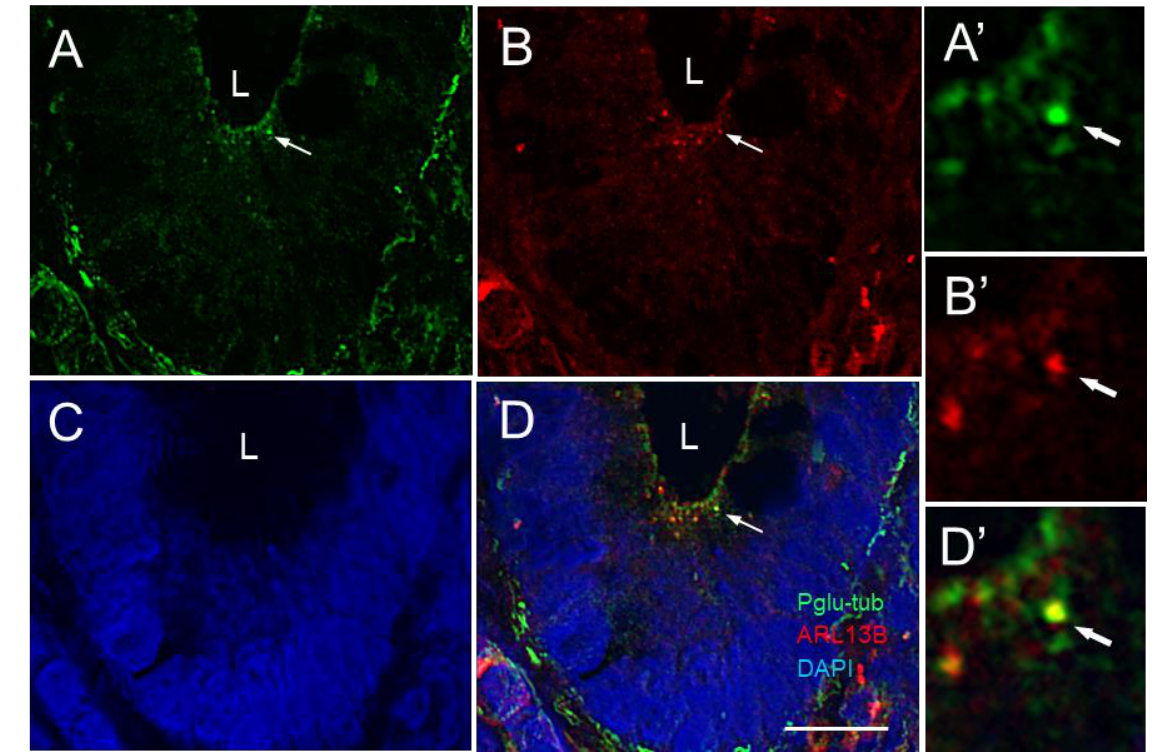
Figure 3. Primary cilia in the lower part of the crypts of the human small intestine. Representative confocal imaging for the detection of primary cilia using anti-glutamylated tubulin (Pglu-tub; green staining, arrow in ( A , D )) and anti-ARL13B antibody (red staining, arrow in ( B , D )) in epithelial cells of the human adult small intestine (L, lumen of the crypt). ( A ’ , B ’ , D ’ ) are higher magnifications of the ( A , B , D ) panels. Nuclei were stained with DAPI ( C , D ). As observed above, the 17711-1-AP antibody ( B , D ) identified dots that were only weakly stained or not stained with the anti-Pglu-tub antibody. Scale bar is equal to 10 µm.